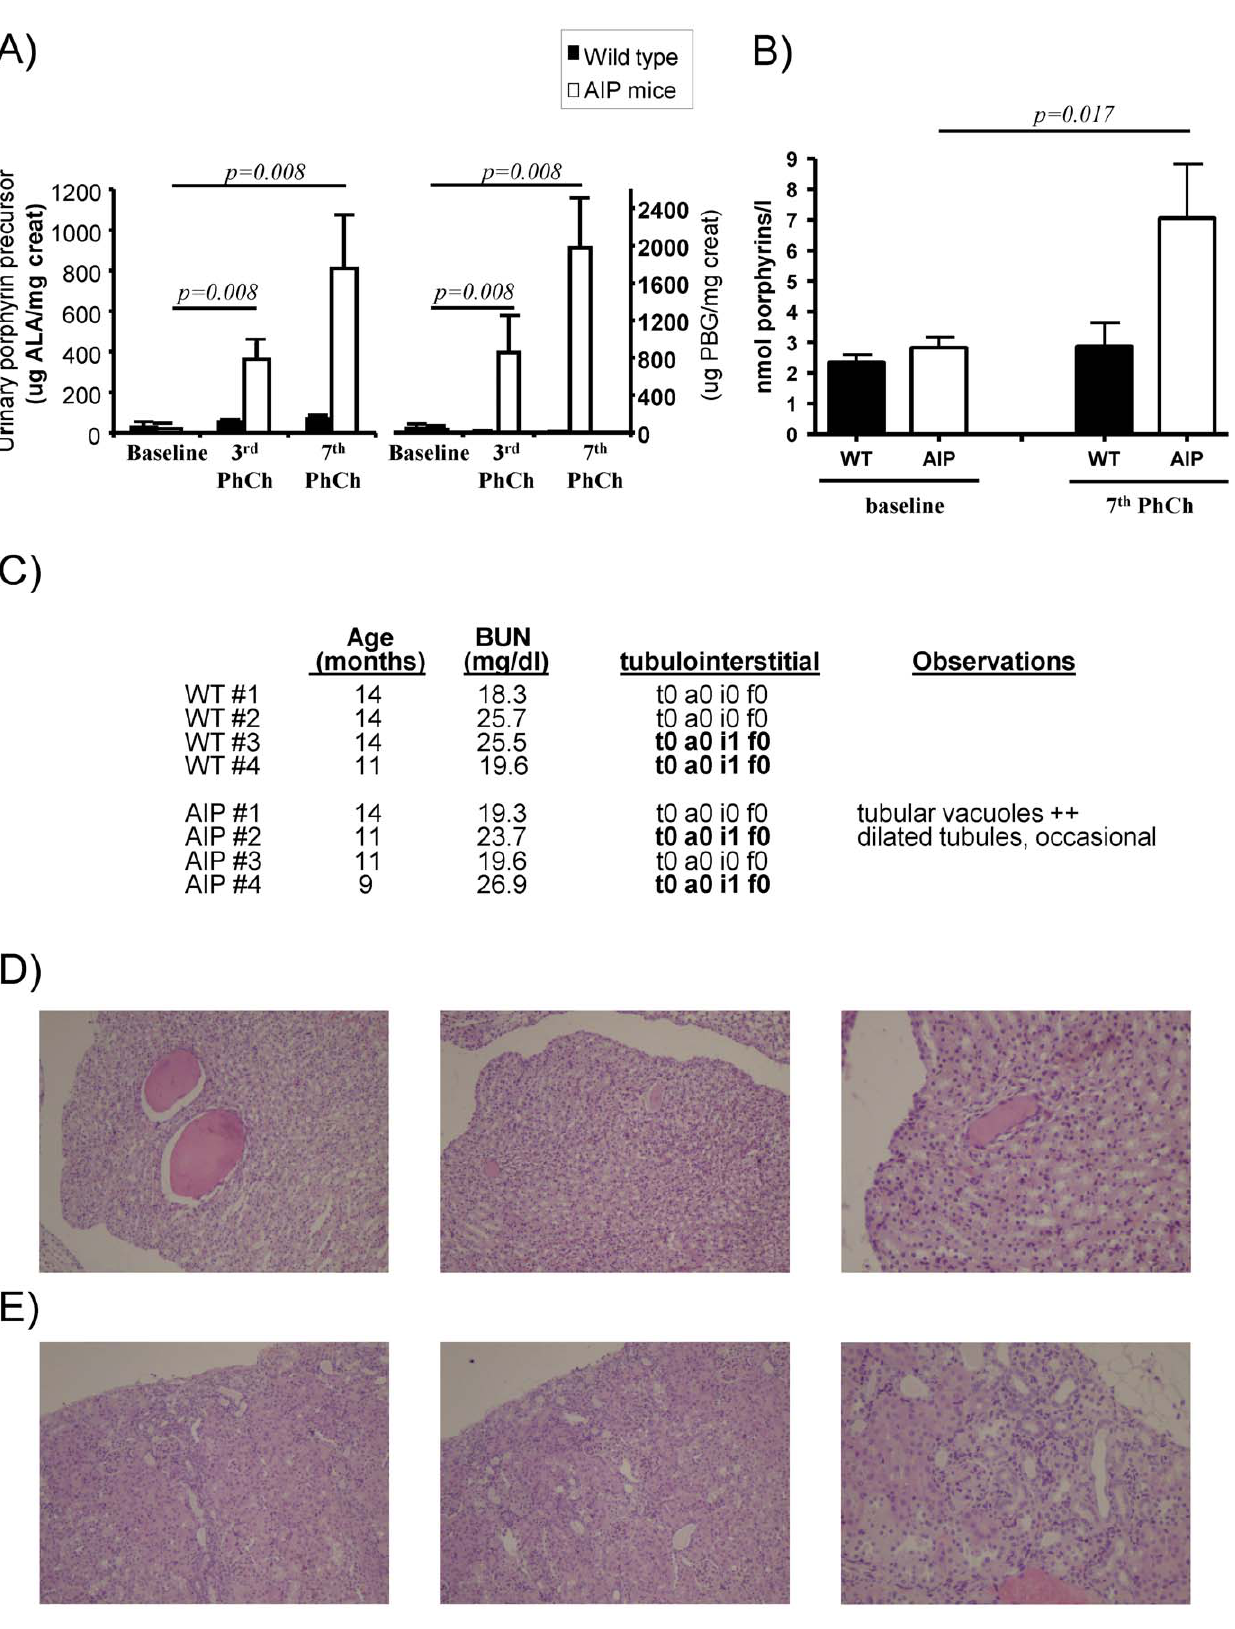
Figure 1. Lack of glomerular, tubulointerstitial or vascular damage in acute intermittent porphyria mice after sustained urinary porphyrin precursors and porphyrin excretion induced by phenobarbital challenge. The effect of repetitive acute attacks on renal function was assayed in four AIP male mice aged from 9 to 14 months. Seven consecutive phenobarbital challenges were administered at intervals of